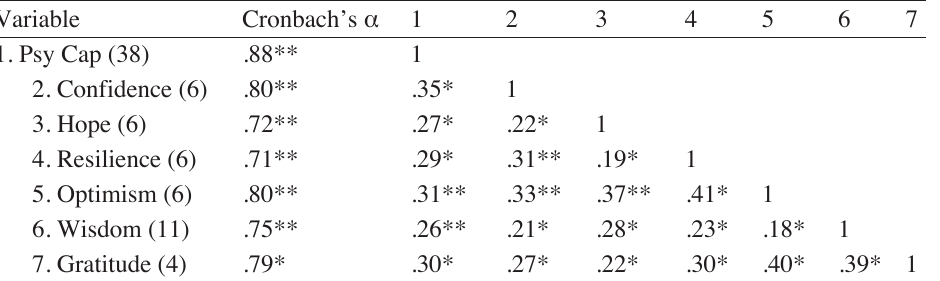
Table 2: Cronbach’s Alpha Coefficients, Bivariate Correlations for